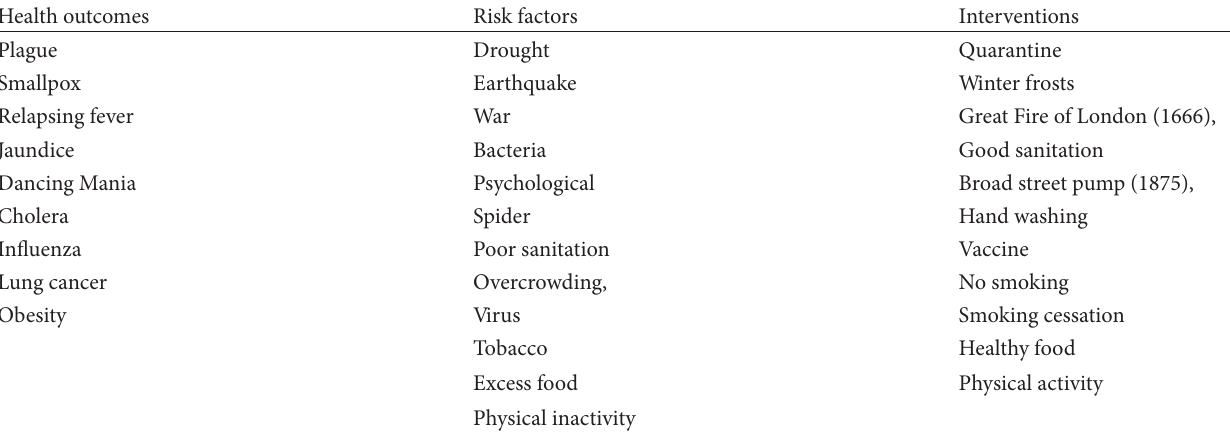
T 2: ree types of information in the historical records of epidemics (based on an analysis of Table 1). Health